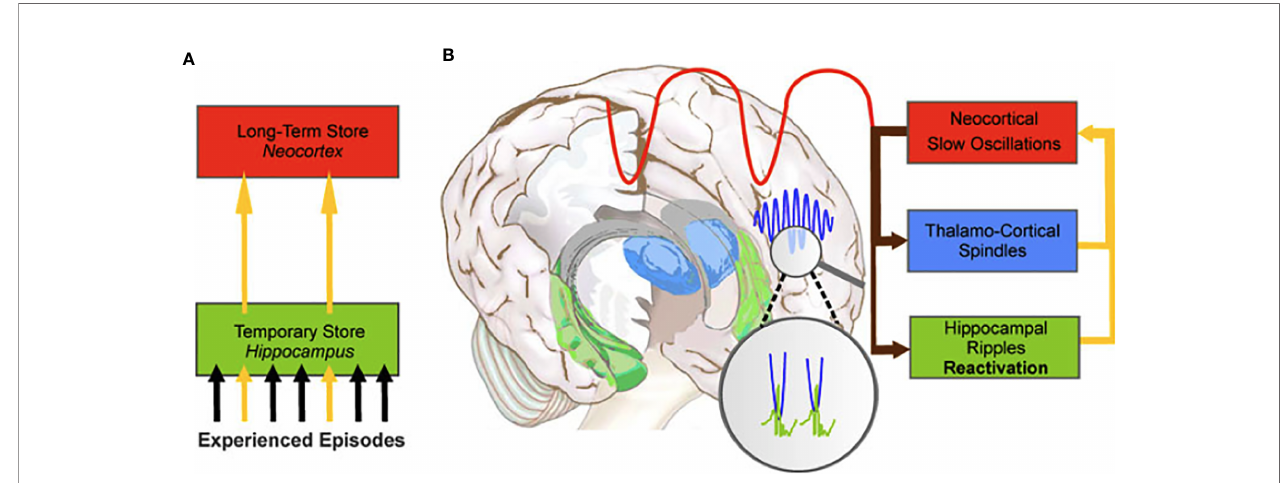
FIGURE 2 | The hippocampal-to-neocortical dialogue. (A) During NREM sleep, memories temporarily stored in the hippocampus are transferred to the long-term store in the neocortex. (B) The dialogue involves the interaction between the slow oscillations, sleep spindles and hippocampal ripples to create spindle-ripple events (magni fi ed circle). From Born et al. (75). System consolidation of memory during sleep. Psychological Research, 76 ,